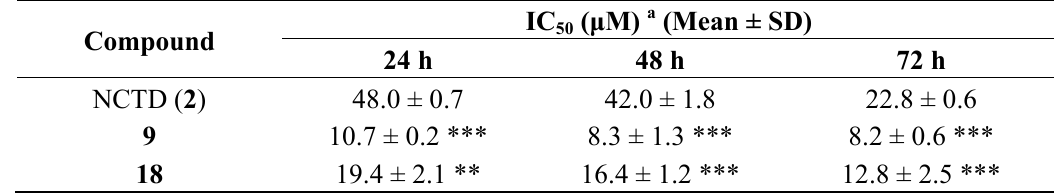
Table 2. Cytotoxic effects of norcantharidin ( 2 ), compounds 9 and 18 against human HepG2 cancer cell lines for 24, 48, and 72 h.